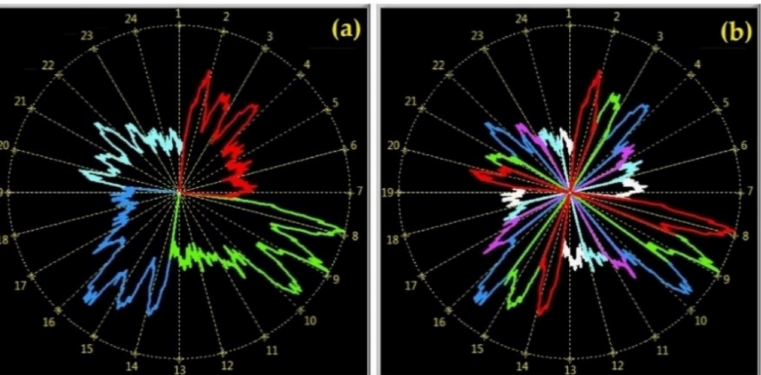
Figure 8. Different colours – different turbine elements: ( a ) runner blades, ( b ) guide vanes ( I (